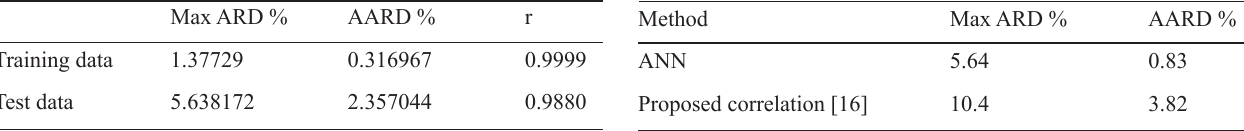
Table 3. Comparison of ANN and equation (12) for Nu of non- Newtonian